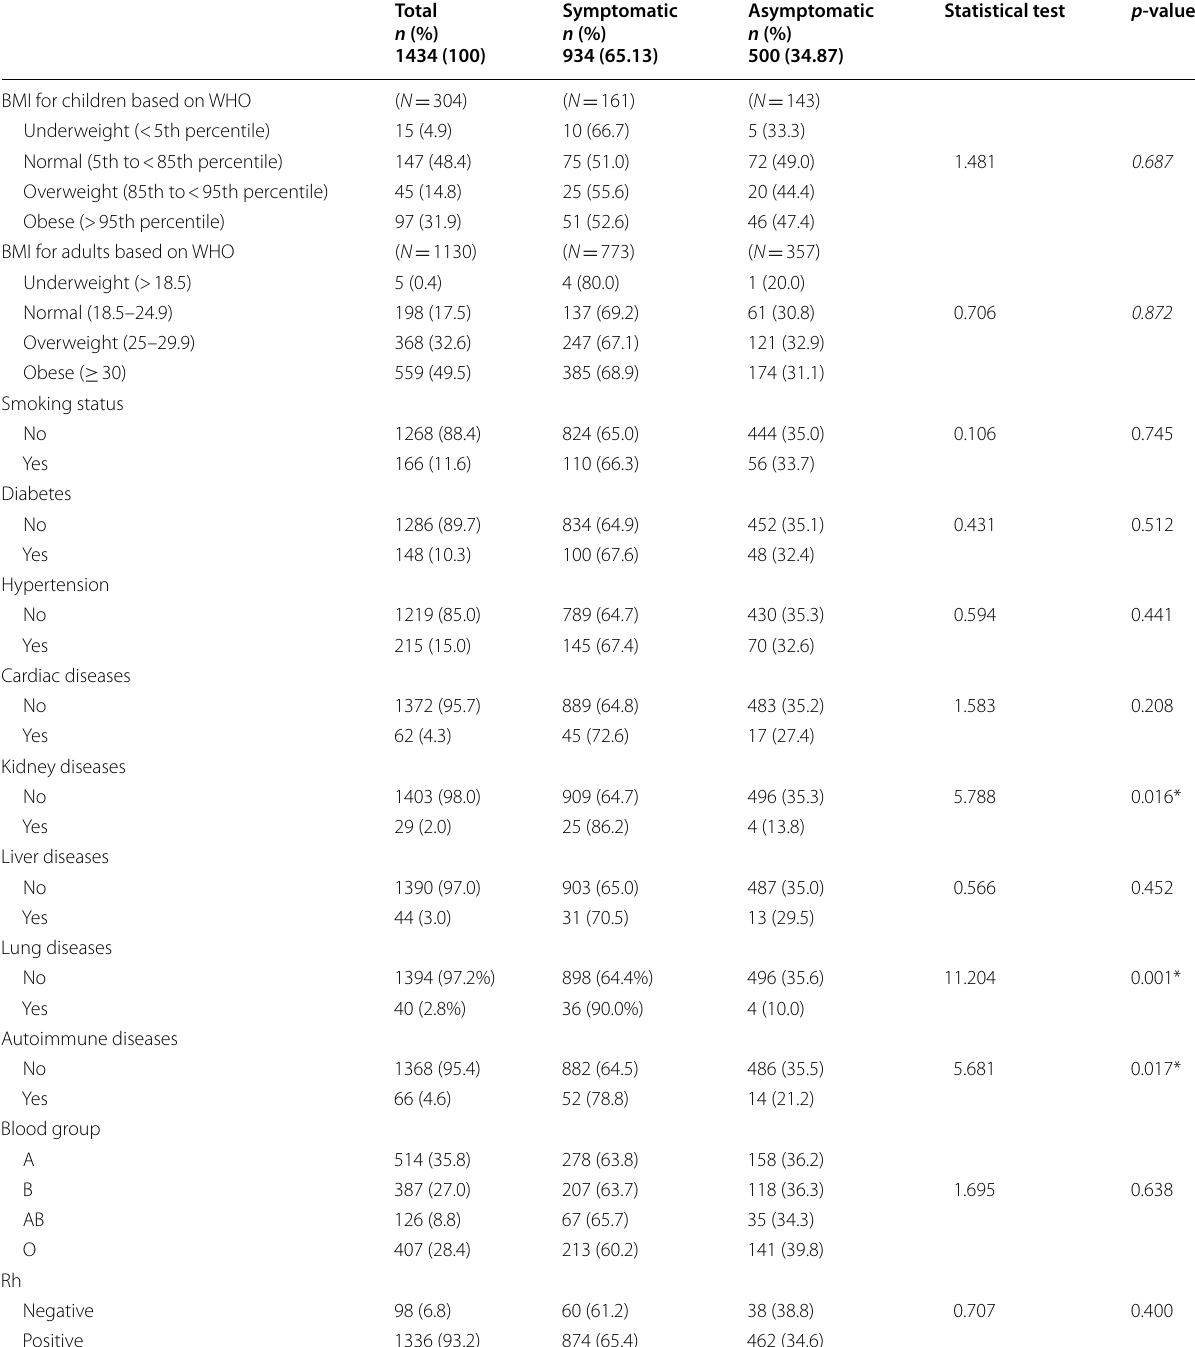
Table 2 Distribution of the symptomatic and asymptomatic participants in relation to their medical